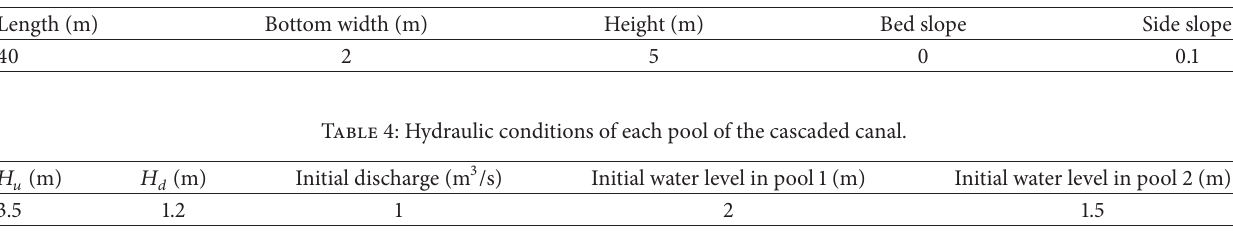
Table 3: Geometric parameters of each pool of the cascaded canal.